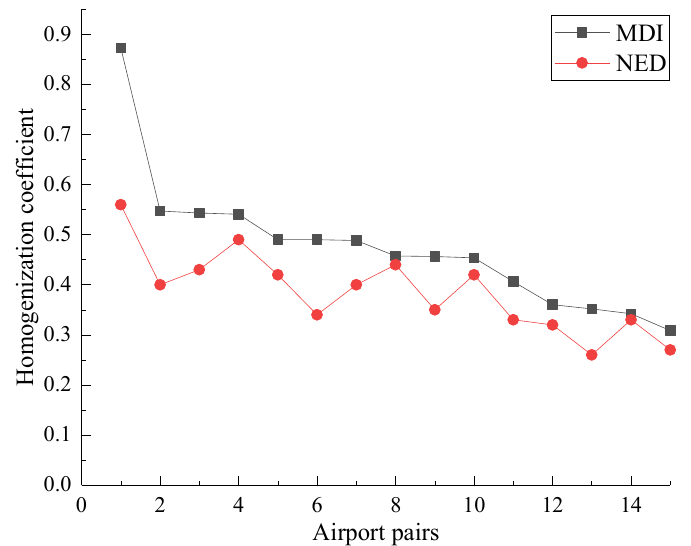
Figure 12. MDI and NED results of the Greater Bay MAR.